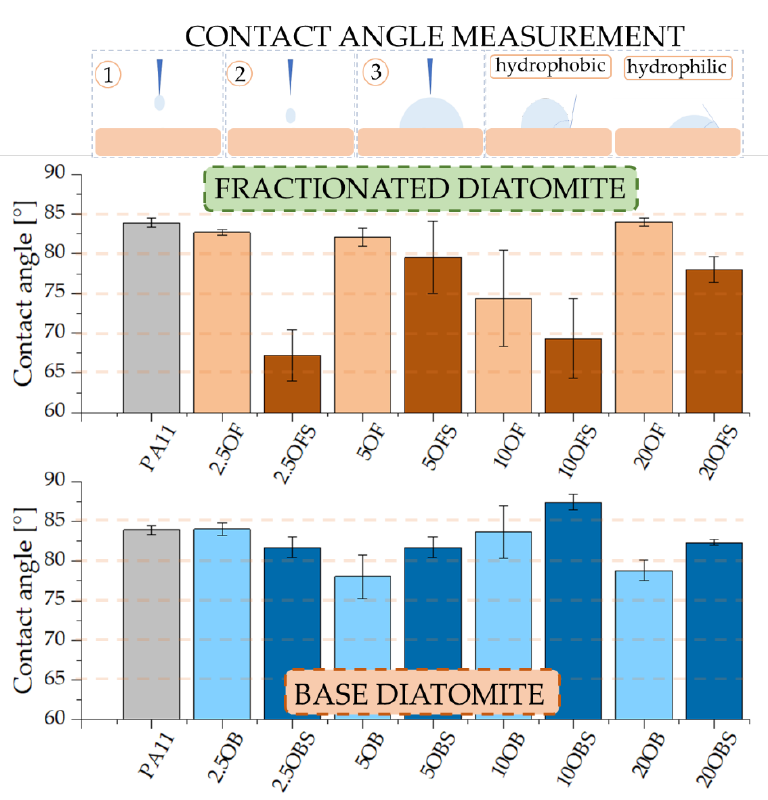
Figure 21. Wetting angle.